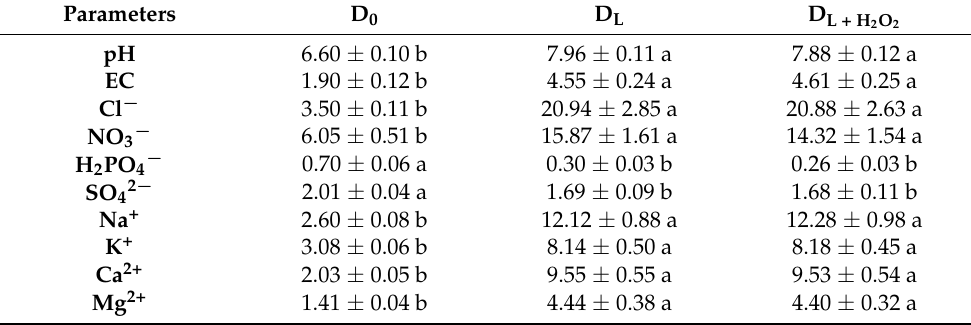
Table 1. Chemical properties of the fertigation in each treatment: D 0 —standard nutrient solution or control treatment, D L —raw leachate treatment and D L + H —raw leachate blended with H 2 O 2 2 O 2 treatment. The experiment simulates a cascade cropping system with different leachate treatments of Chrysalidocarpus lutescens as primary or “donor” and Dracaena deremensis as a secondary or “acceptor” plant culture. The nutrient concentration was expressed in mmol L − 1 and EC was expressed in dS m − 1 . The results are the average values ± standard deviation of four samples per fertigation treatment during the experimental